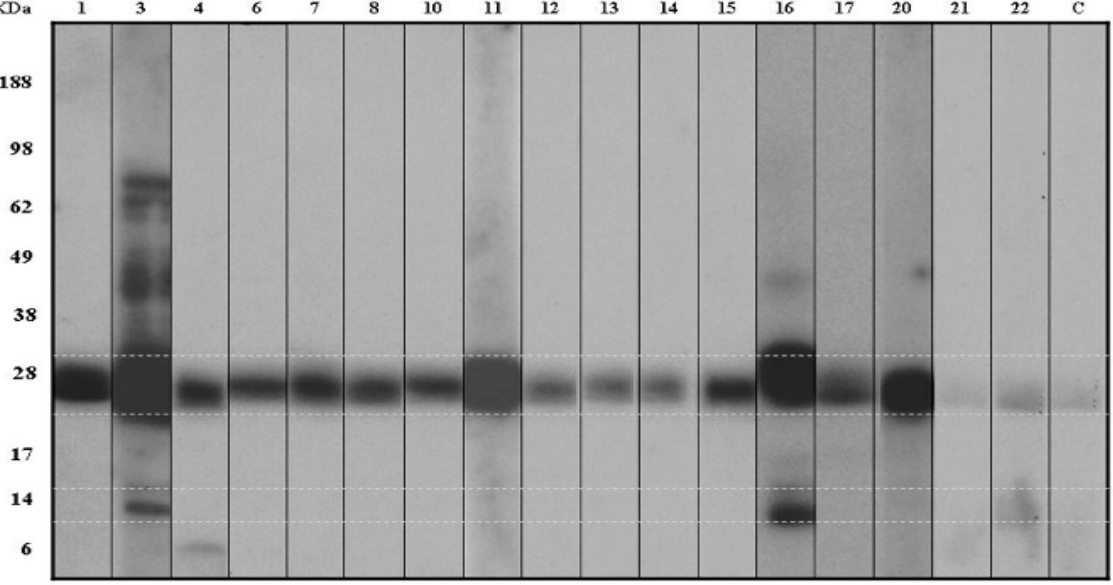
Figure 2. Immunolabelling with sera from 17 patients with kiwifruit allergy. Lower and upper marks indicate Act d 5 at 15 kDa and Act d 1 and Act d 2 at 28 and 24 kDa. C: negative control.